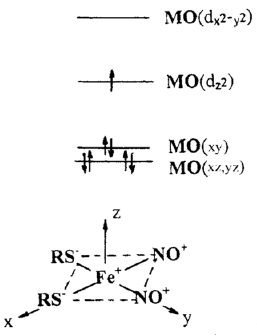
Figure 19. The hypothetical electronic and spatial structures of M-DNIC with thiol-containing lig- ands in aqueous solutions